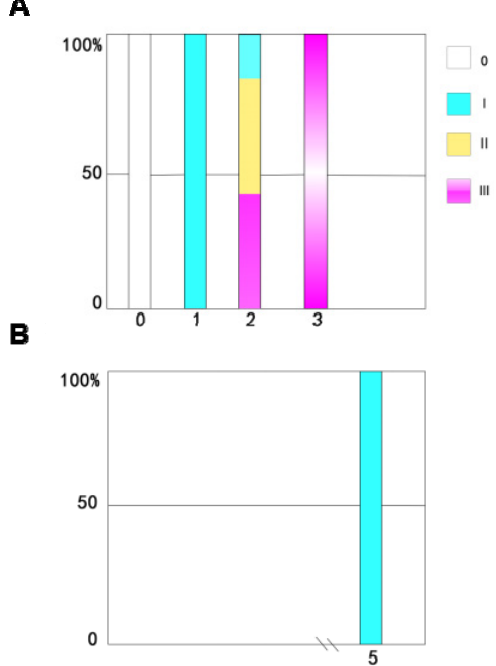
Figure 4. Time course of ovarian development in the non-diapause adults of N. barkeri reared at 25 °C ( A ) and the stages in ovarian development in the diapause adults reared at 18 °C ( B ). The sample size for each histogram is 30.